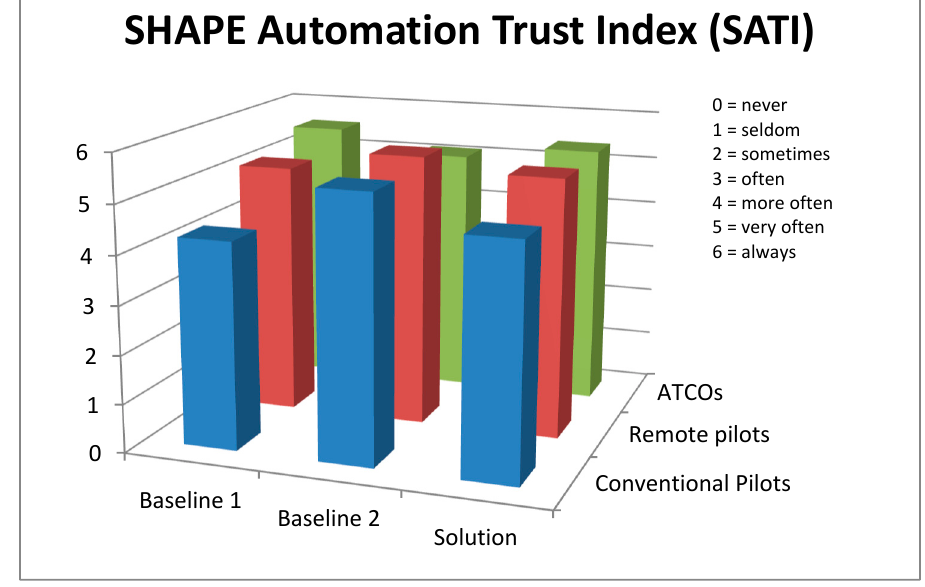
Figure 5. Results of SATI questionnaire, per scenario and expert group.